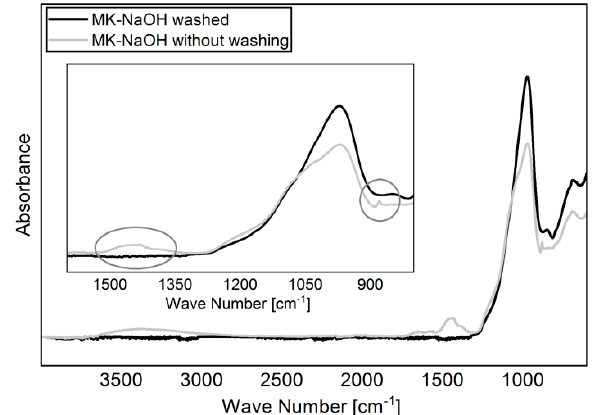
Figure 1. FTIR spectra of dried MK-NaOH after and without prior washing the sample. The carbonization of adhered NaOH to the particle surfaces can be avoided by washing the sample.